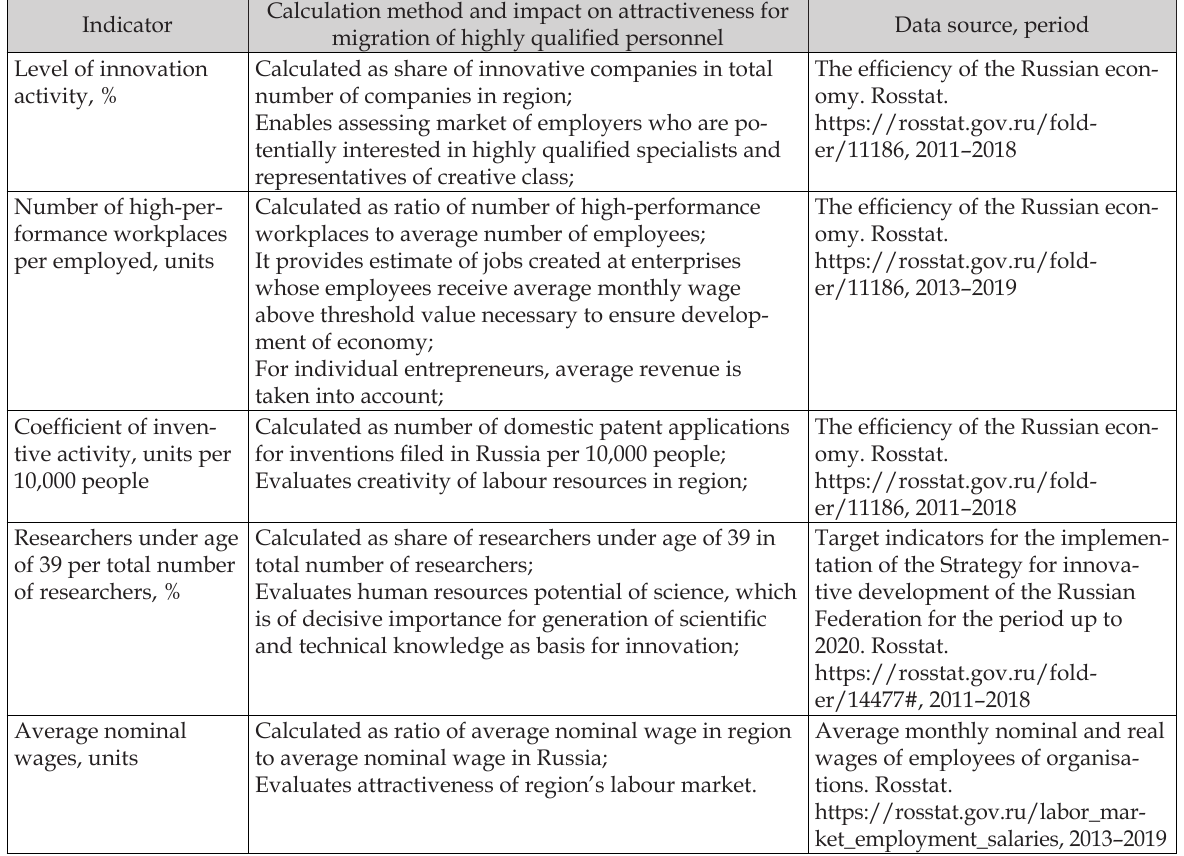
Table 1. Methodology for calculating the innovation attractiveness